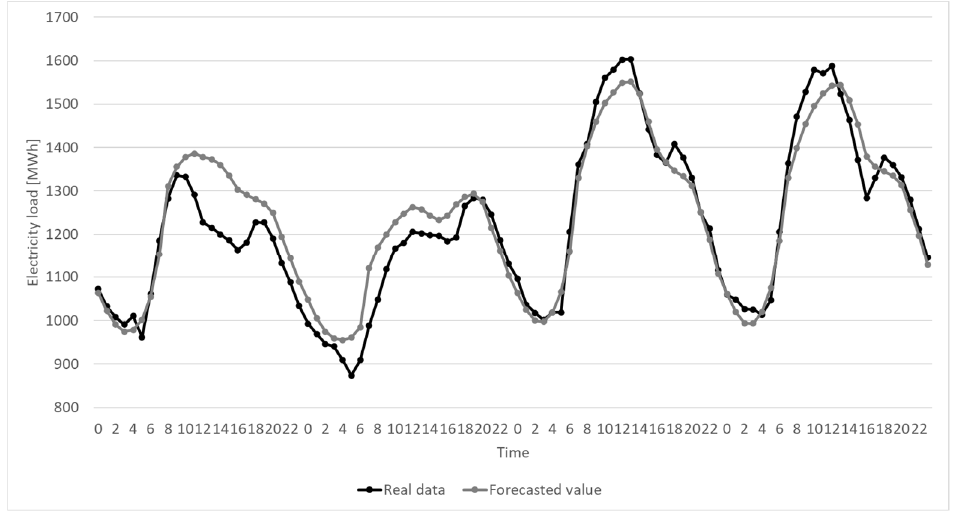
Figure 2. Actual vs. predicted electricity load in experiment 1.